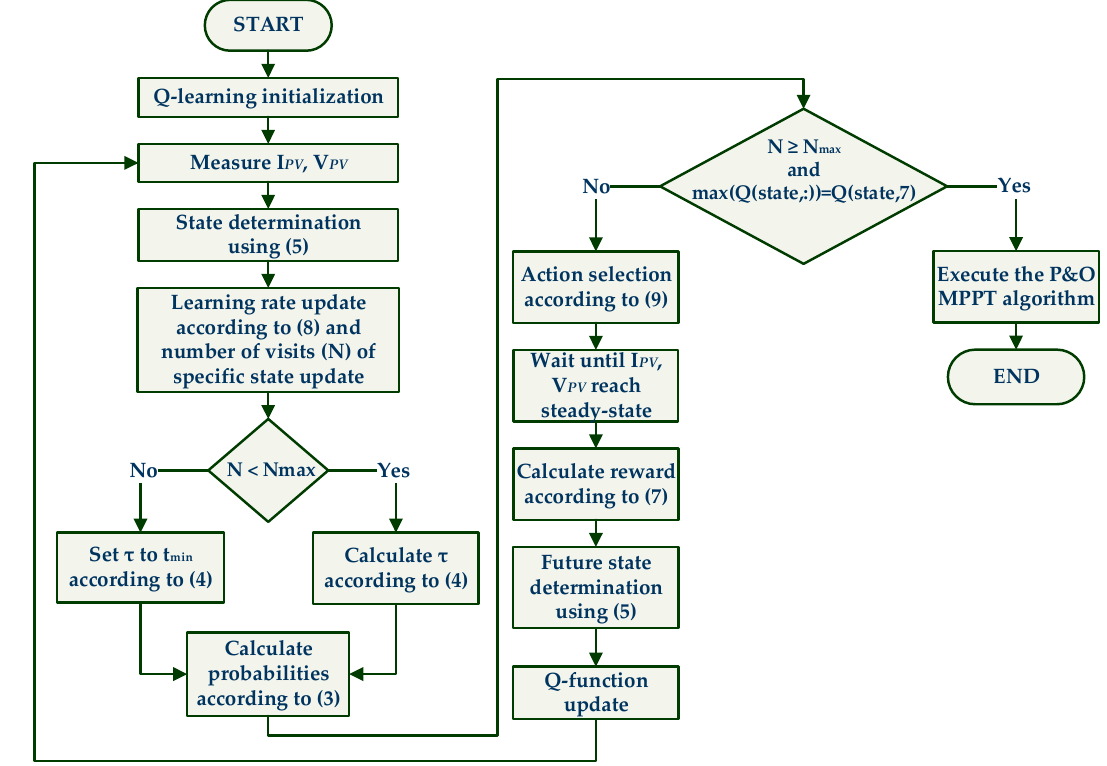
Figure 4. A flowchart of the proposed Q-learning-based PV GMPPT algorithm.